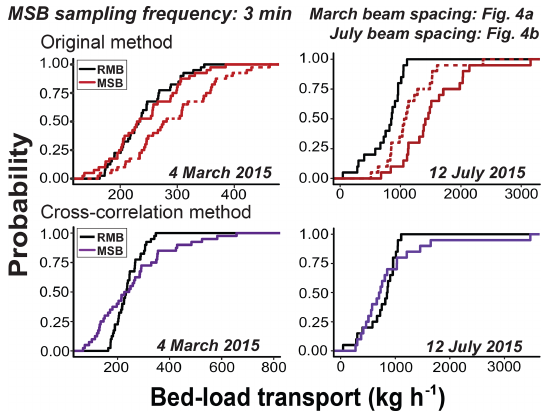
Figure 5. CDFs of lag-corrected repeat multibeam (RMB; black) and multiple single-beam (MSB) bed-load transport estimates us- ing the original (red) and cross-correlation (purple) to calculate bed- form celerity for the multiple single-beam profiles. Dashed red lines are sine-corrected estimates. Sampling frequency is 3min. March beam spacing is the same as Fig. 4a. July beam spacing is the same as Fig.